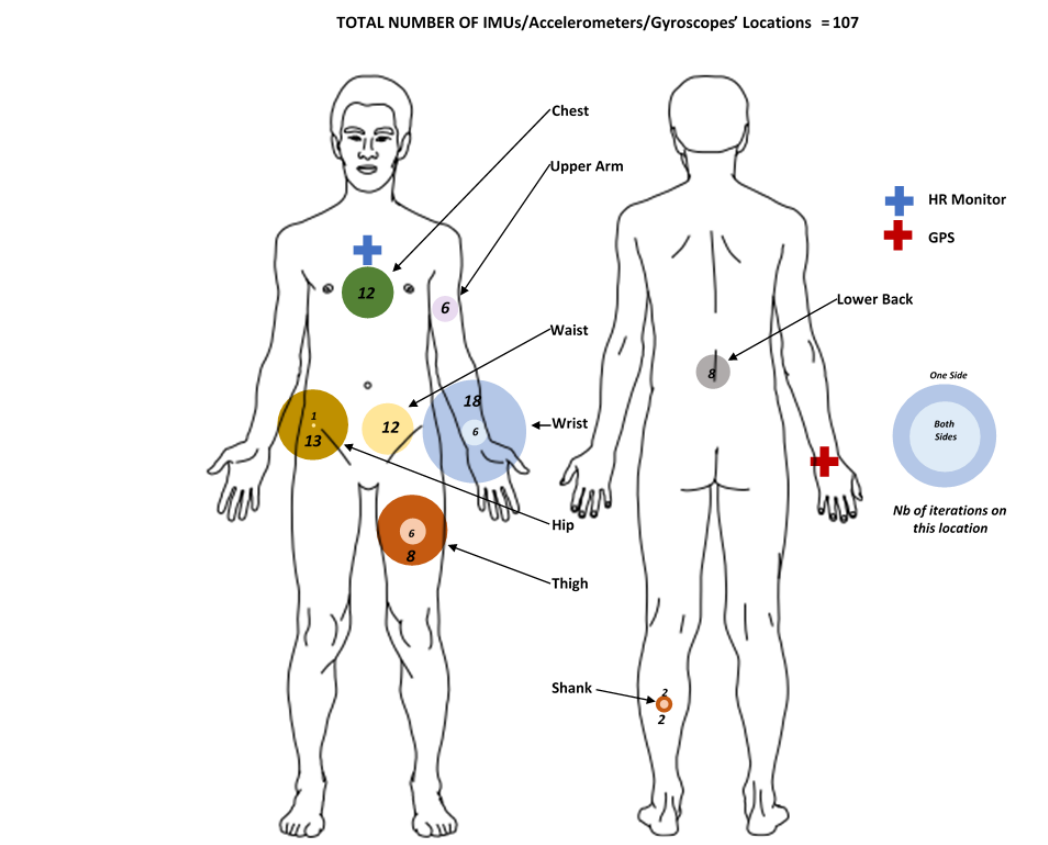
Figure 5. Sensors (IMUs, Accelerometers, gyroscopes, and other kind of sensors: GPS and Heart Rate Monitors) placements. Each circle displayed on the graph shows the proportion of use of the location associated with it (its radius is matched with the number of times that location is used in relation to the total number of locations used). Within these circles, another light-colored circle may be displayed which represents the proportion of the number of times the sensors placed on the location of the circle are placed on both sides of the participant. The remaining dark part represents the proportion of the number of times the sensors placed on the same location are placed on only one side of the participant. The numbers within each of the dark and light parts of the circles indicate the precise number of times each of these specific situations occur. The average position of the other sensors (GPS and HeartRate Monitors) are also indicated by crosses.